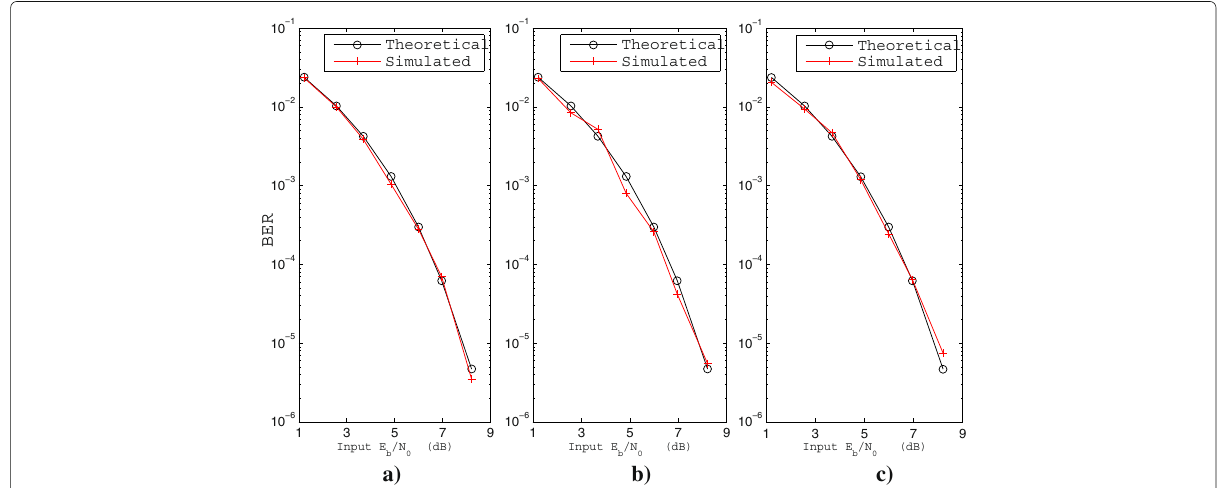
Fig. 6 BER comparisons of D-BFT detection among single-chirp-rate and multichirp-rate signals. The figure compares the BER performances by the theoretical analysis and the simulation. a BFT BER of Single -Chirp-rate Signal. b 1st-rate BFT BER of the Multiple-Chirp-rate Signal. c 4th-rate BFT BER of the Multiple-Chirp-rate